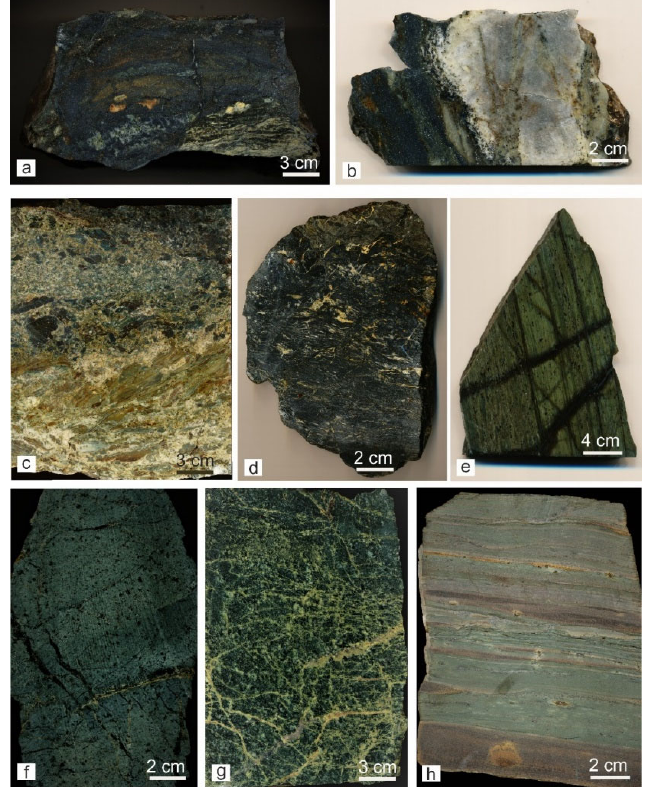
Figure 5. Rock fragments from serpentinitic mélange matrix in contact with marly shales N of Dobšiná (a)–(e): ( a ) Blueschist layer (dated sample DOL ‐ 1) in Tlc ‐ Phg ‐ Chl ‐ Cal schist (lower right ‐ hand corner). ( b ) Blueschist layer in marble. ( c ) Tectonized contact of a blueschist (top) and Tlc ‐ Phg ‐ Chl ‐ Cal schist with pale calcite mobilizates. ( d ) Blueschist mylonite. ( e ) Serpentinized harzburgite mylonite. Metabasalt layers in metaradiolarites S of Dobšiná (f)–(g). ( f ) Metabasalt (sample DO ‐ K12). ( g ) Metadolerite (sample DO ‐ K13). ( h ) Jurassic calciturbidites (sample DO ‐ F) composed of calcareous shales with millimetric to centimetric greenish clayey ‐ marly and brownish carbonate ‐ rich sandy layers (a quarry N of Dobšiná).